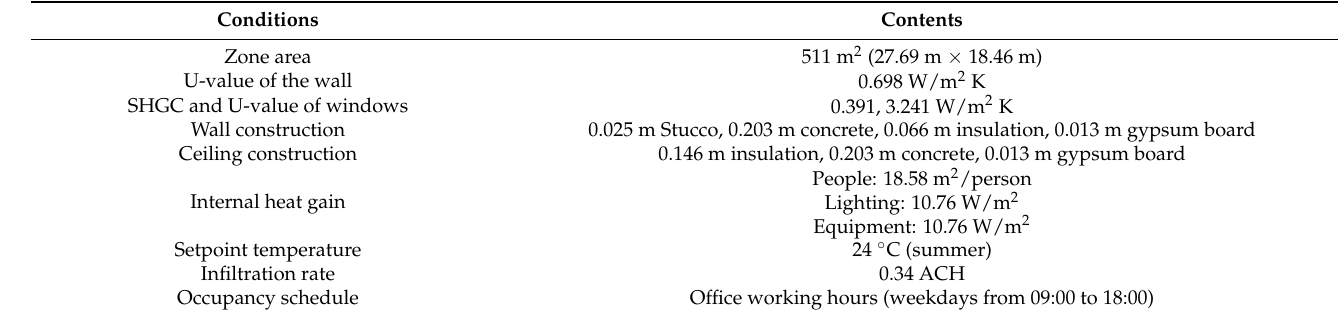
Table 2. Boundary conditions used in the